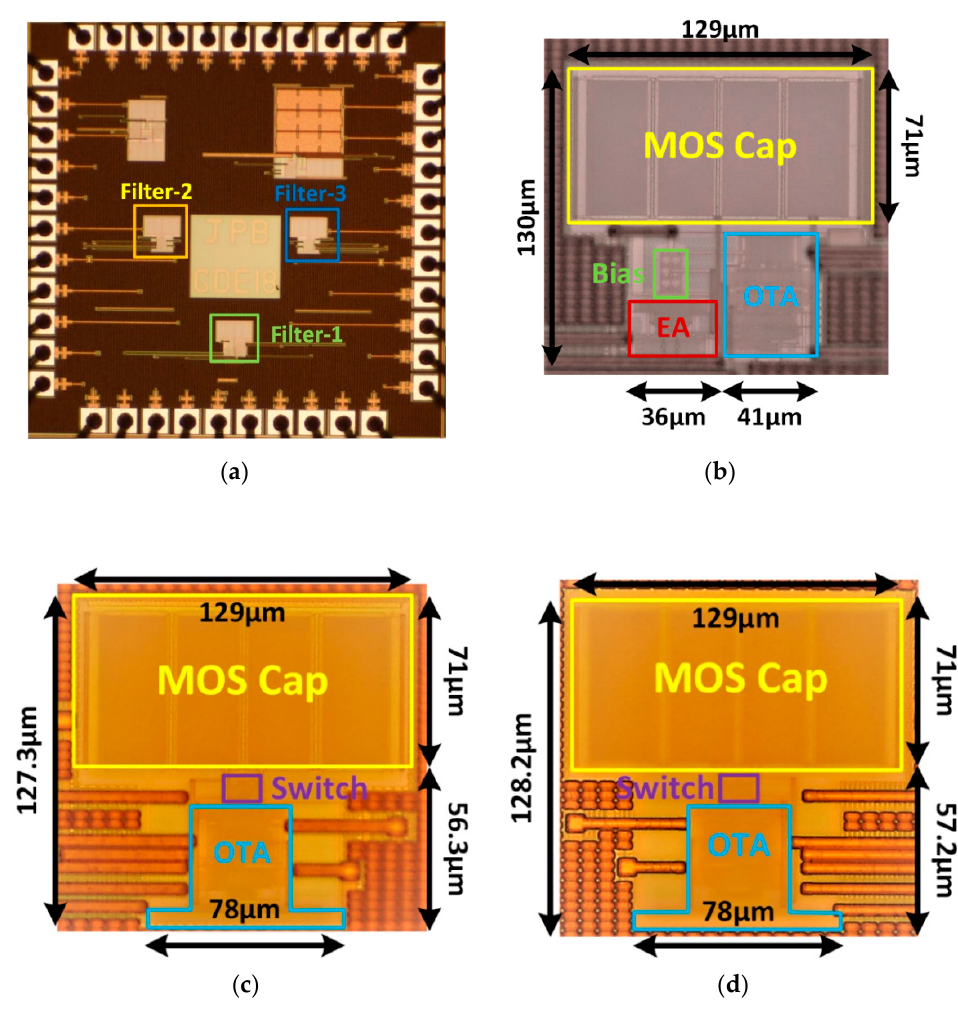
Figure 7. Microphotograph of: ( a ) complete integrated die (1525 µ m × 1525 µ m); and zoomed image of ( b ) Filter-1; ( c ) Filter-2; and ( d ) Filter-3.